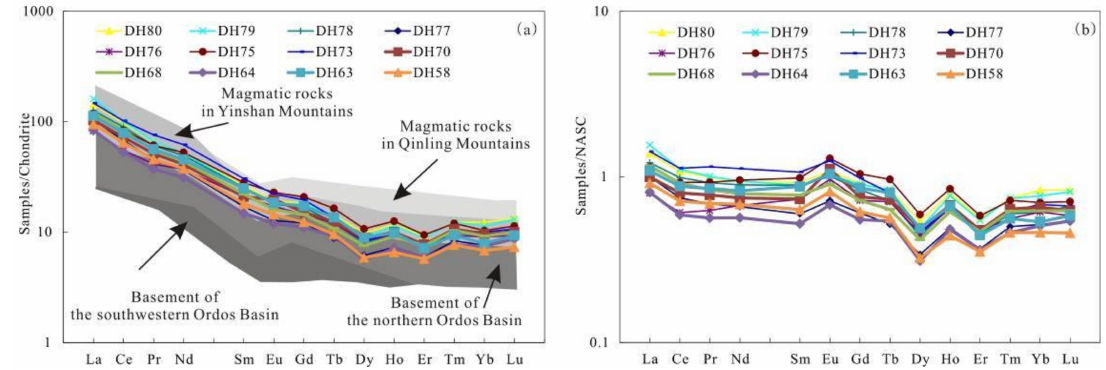
Figure 5. ( a ) Chondrite-normalized distribution pattern of rare earth elements (REEs) (the base map is from Qiu et al. [14]) and ( b ) North American shale composite (NASC)-normalized distribution pattern of